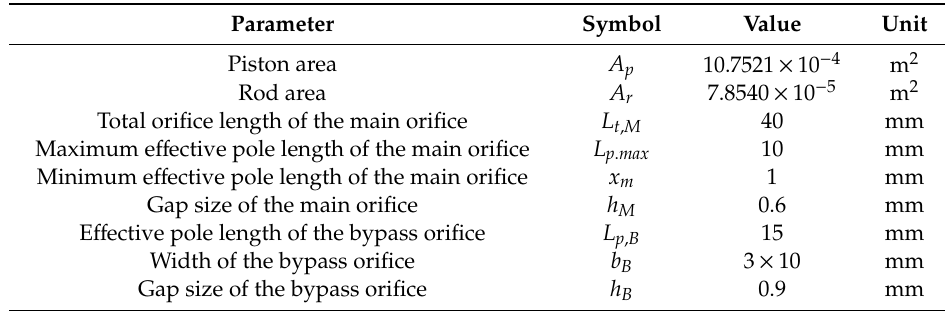
Table 2. Design parameters of MRD-PSF.